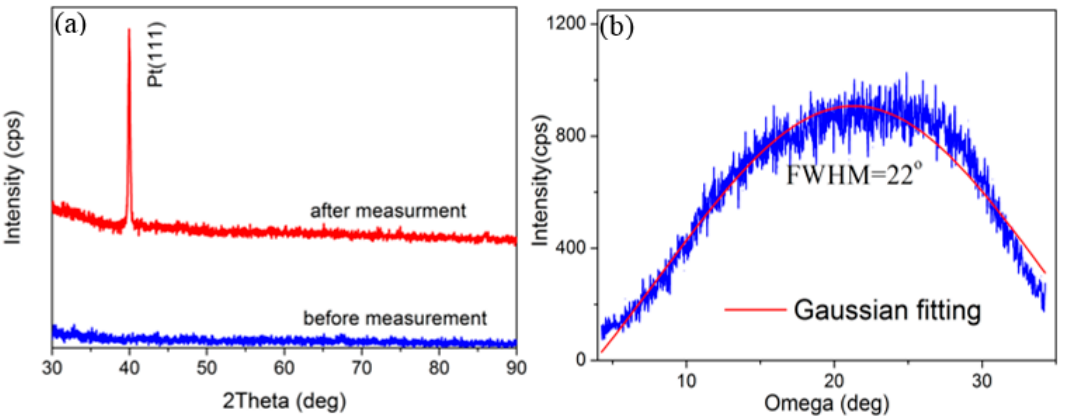
Figure 3. ( a ) θ –2 θ scans of AlN/Pt/LGS samples before and after high temperature measurement; ( b ) Rocking curve of Pt (111) of AlN/Pt/LGS samples after high temperature measurement.